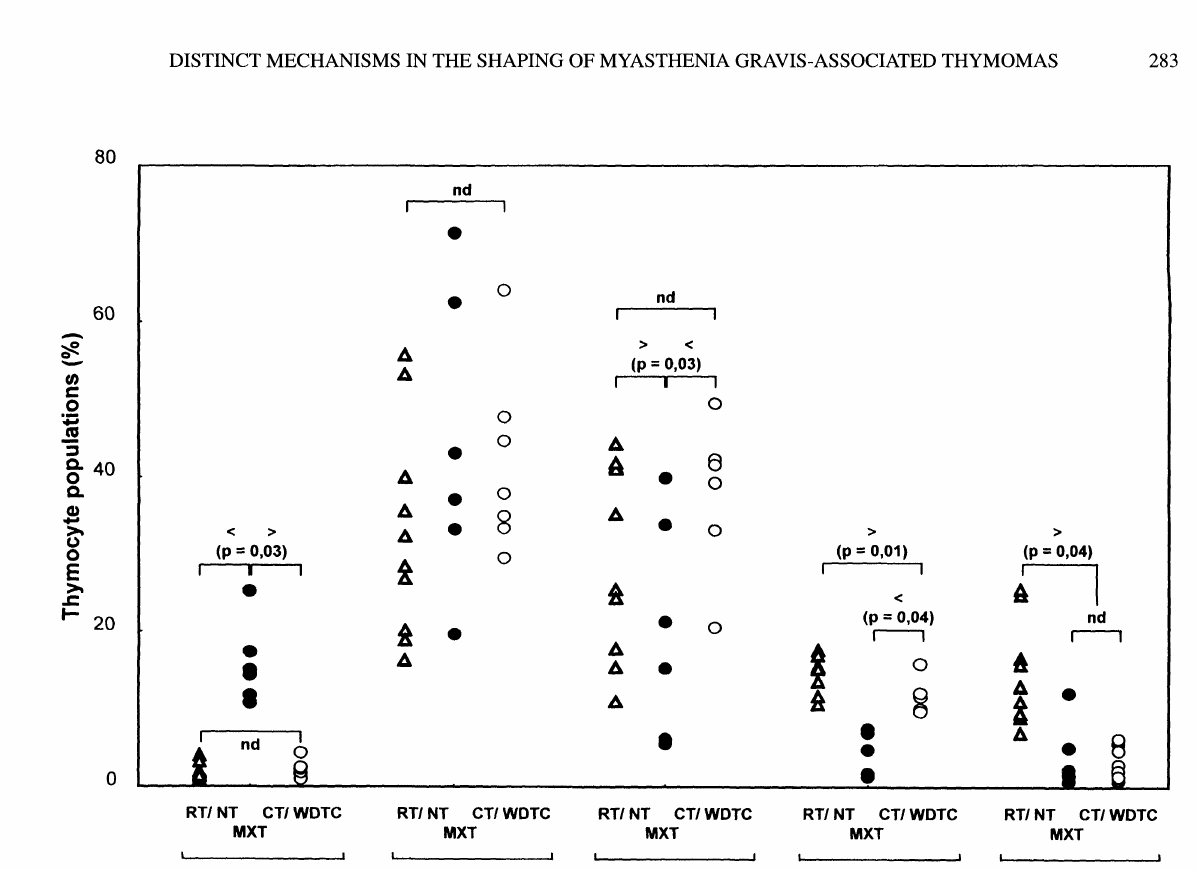
FIGURE 2 FACS analysis of main T cell subsets revealed significant differences in thymocyte maturation between mixed (MXT) and corti- cal thymomas well differentiated carcinomas (CT WDTC). In mixed thymomas, the majority of cells was lost before entry into positive selection, i.e. at the transition from the CD3-4+8+ to the CD3+4+8+ stage. However, the few positively selected (CD69+4+8+) cells in these tumors seemed to reach the mature CD3+4+8- stage. In cortical thymomas and well differentiated carcinomas, the numbers of positively selected cells were significantly decreased but still roughly comparable to residual and control thymuses (RT NT). However, most of these cells were obviously eliminated before reaching the CD4 stage. Maturation ofthe CD8 lineage in all thymomas was undistinguishable from control thymuses (not shown). (nd: not statistically